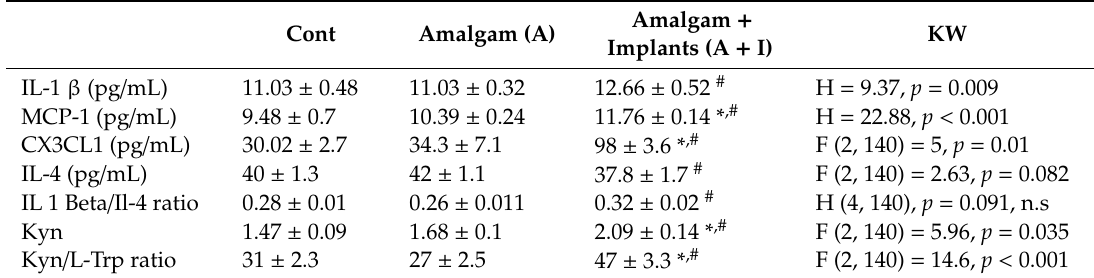
Table 1. Systemic cytokine levels and L-kyn / L-trp ratios.